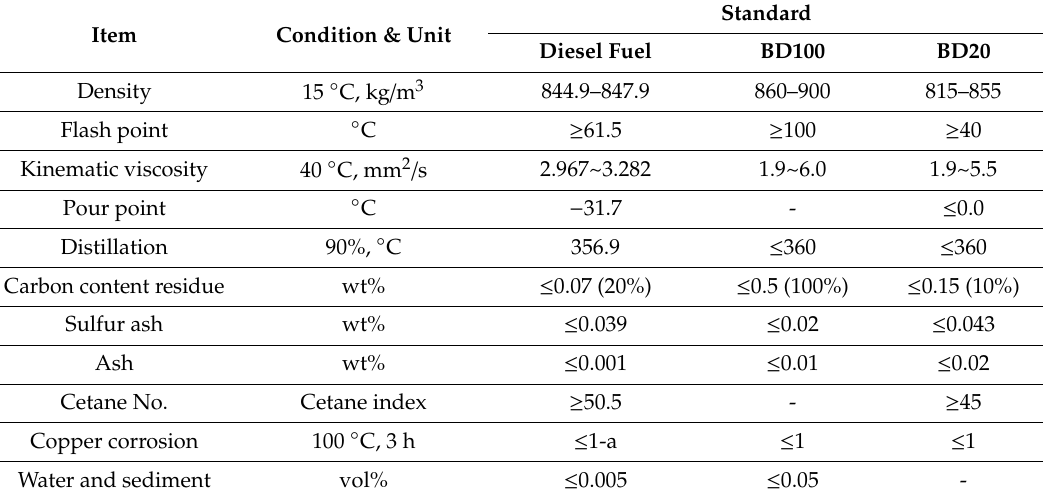
Table 3. Quality standard of diesel fuel, BD100 and